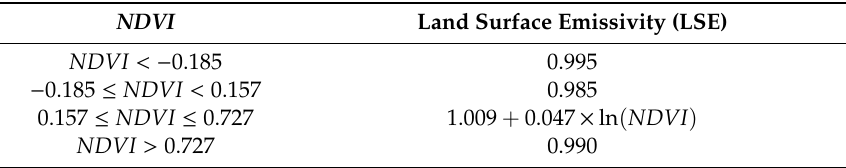
Table 3. NDVI (Normalized Di ff erence Vegetation Index)-based algorithm